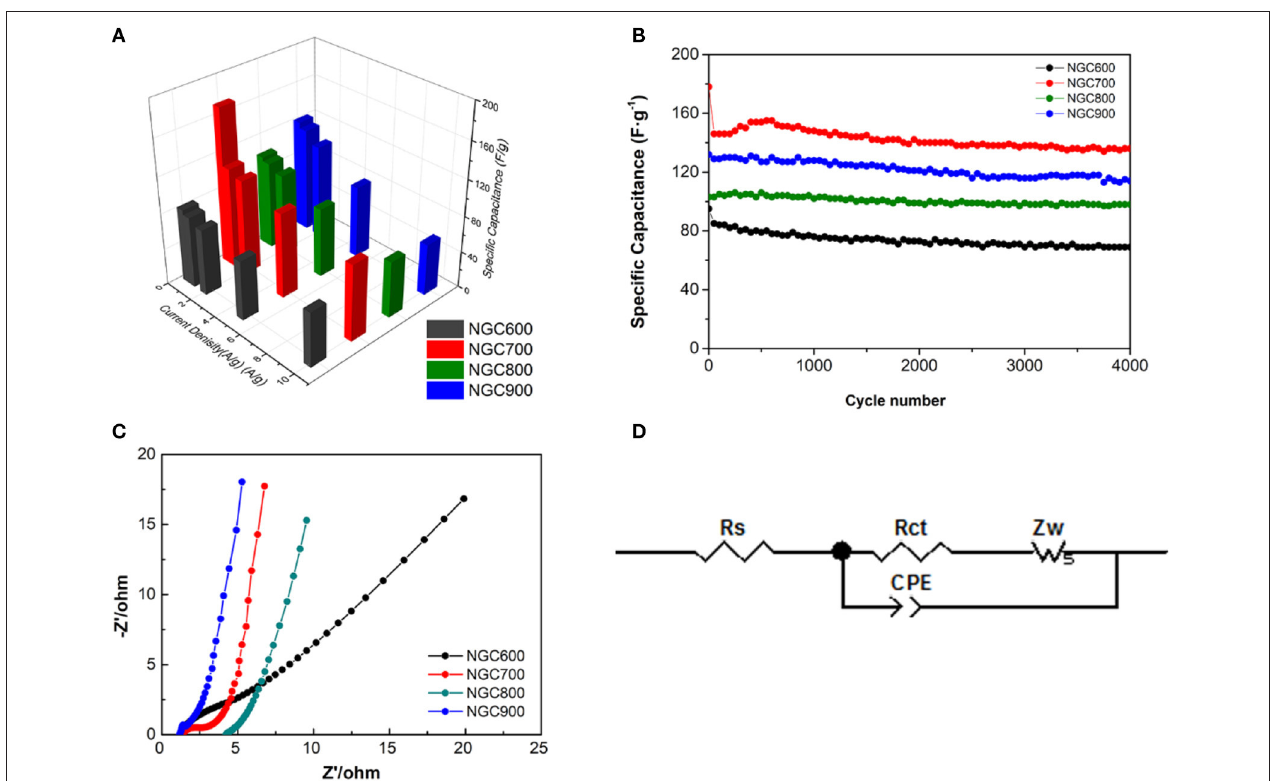
FIGURE 7 | (A) The correlation of specific capacitances with scan rates for the composites. (B) Cycling performance of NGCs at a current density of 0.5 A · g − 1 . (C) Nyquist plots of the NGCs and (D) Equivalent circuit of the EIS measurements.